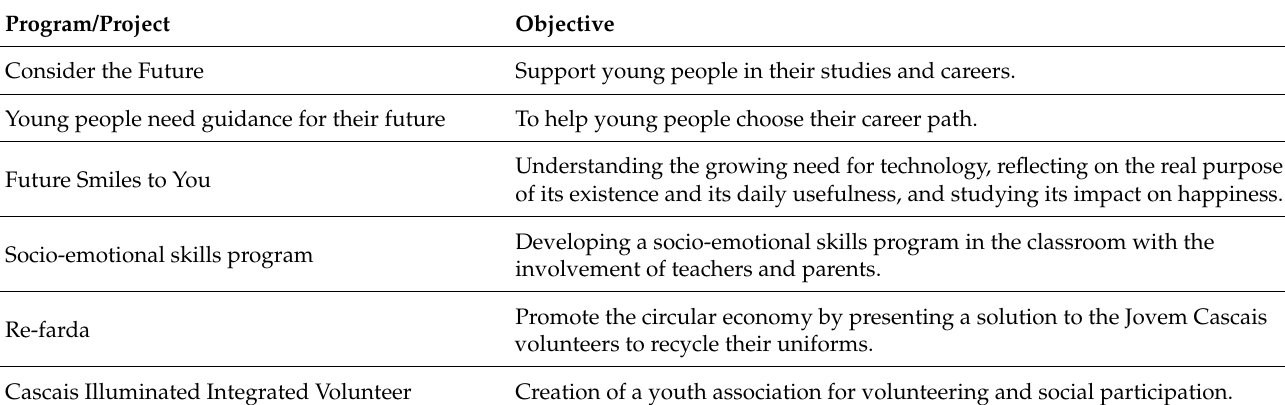
Table 4. Youth Ideas and their Objectives